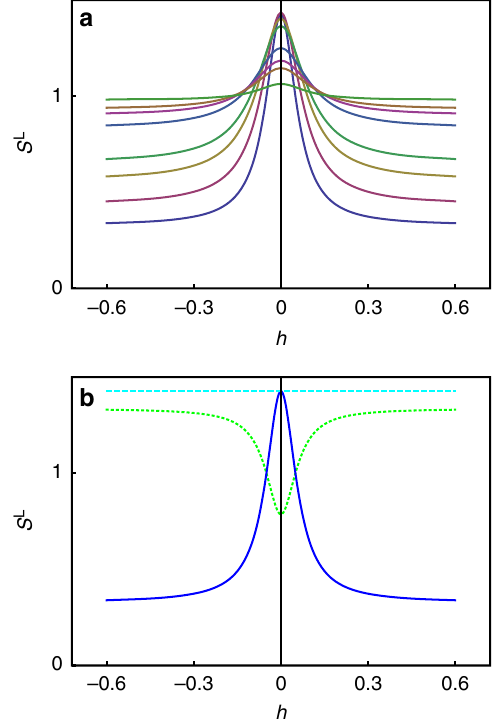
Fig. 6 Harmonic phase corrected for monopole screening. a Predicted longitudinal correlation function in spin ice (Eq. (20)) along [ h , h , 2] at temperatures of (top to bottom on right hand side) 50, 20, 10, 5, 3.75, 2.5 and 1.7 K. The calculation requires an input of the Debye length and susceptibility as a function of temperature. The Debye length was calculated iteratively by Debye – Hückel theory for single and double charge magnetic monopoles 49 with excess chemical potentials appropriate to the was augmented by the distance of closest monopole approach as the standard extension of Debye – Hückel theory). The susceptibility used was an analytic approximation to the experimental data of Ho 2 Ti 2 O 7 31 , as in Fig. 5. This plot may be compared with that of Fennell et al. 23 , Fig. 2D. The scattering separates into a fl at component (the harmonic phase) and a central Lorentzian component arising from magnetic monopoles. b Corresponding longitudinal (blue full line) vs. transverse (cyan long dash) scattering functions from Eq. (19) at 1.7 K. The green short dash curve represents the transverse scattering function corrected to obey the total moment sum rule. This may be compared to the result of Fennell et al. 23 , Fig. 2B,